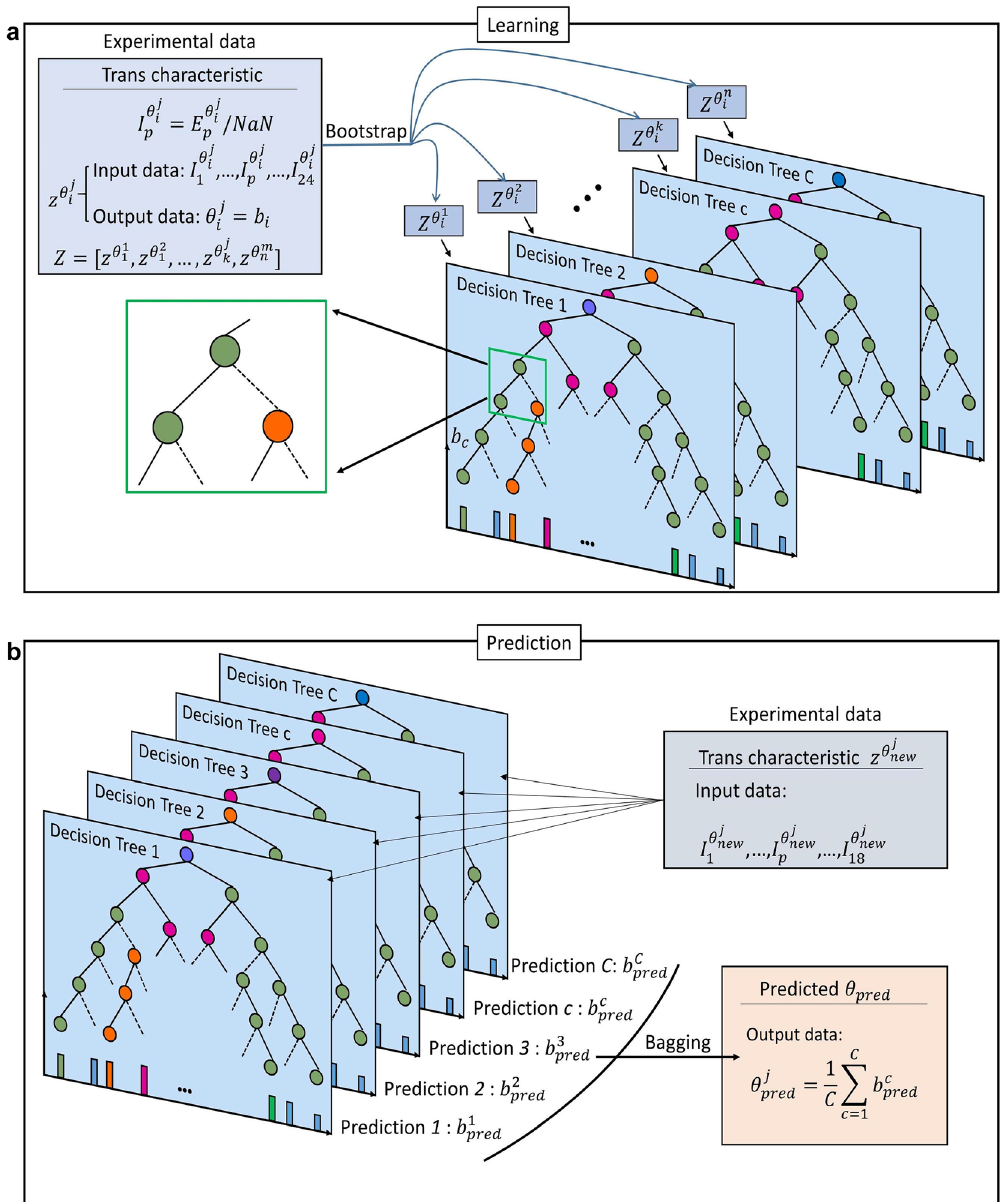
Figure 3: Schematic and working principle of RF. It creates many decision trees to learn the relationship between the distribution of the field intensity and the direction of the incoming